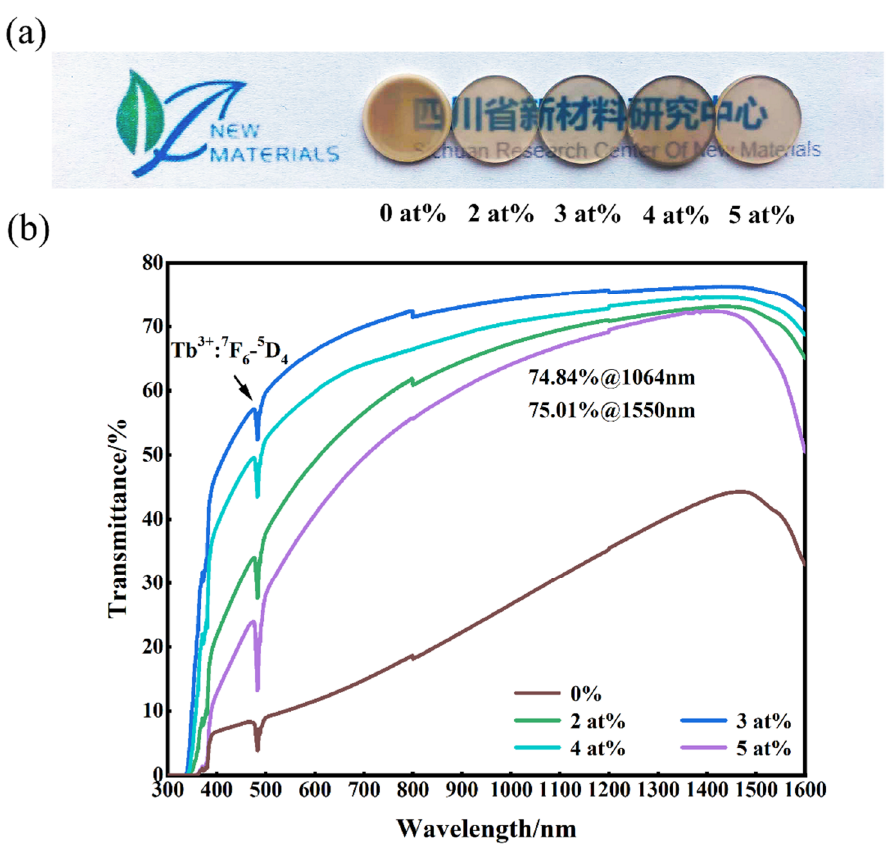
Figure 6. Photograph ( a ), and in-line transmittances curves ( b ) of the mirror–polished (Tb 0.7 Lu 0.3 ) 2 O 3 ceramics sintered at 1550 °C followed by HIP at 1575 °C. (Zirconia content from left to right is 0 at%, 2 at%, 3 at%, 4 at% and 5 at%).